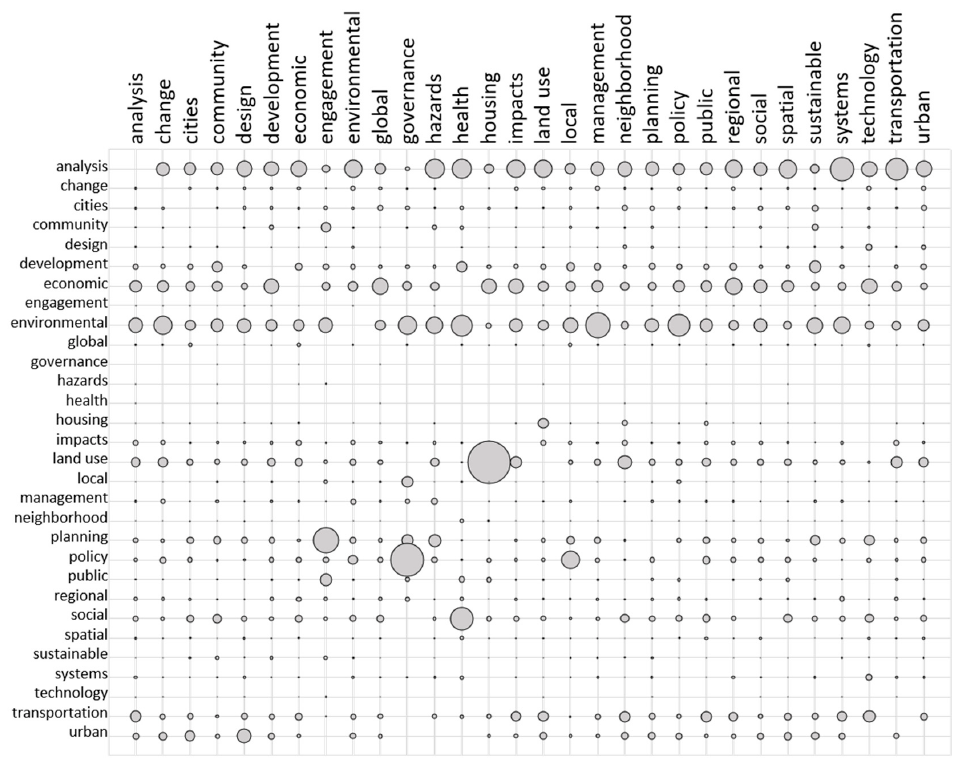
Figure 1. Co-labelling distribution across publication themes.